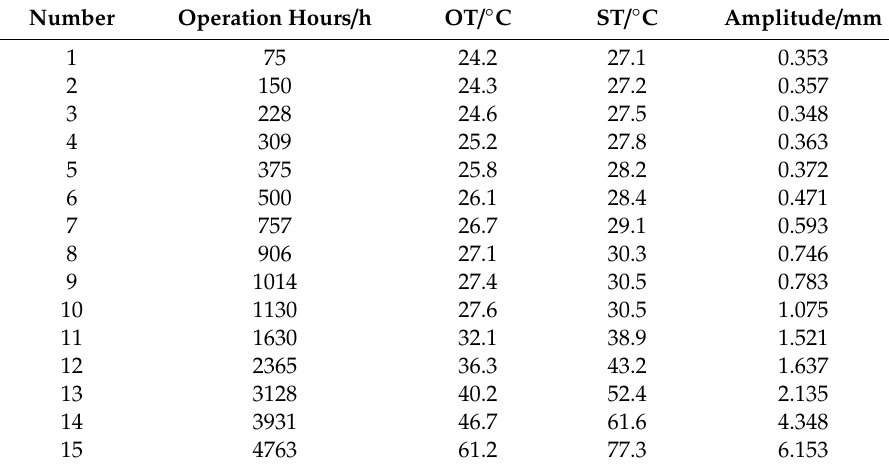
Table 2. Partial state monitoring data of the